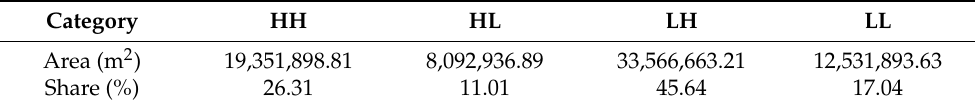
Table 10. Distribution of coupling coordination type between spatial quality and public sentiment in lakefront area.